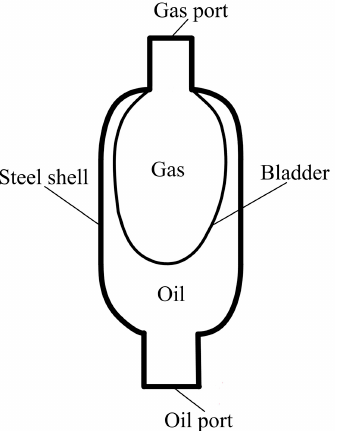
Figure 6. The structure diagram of the bladder accumulator.